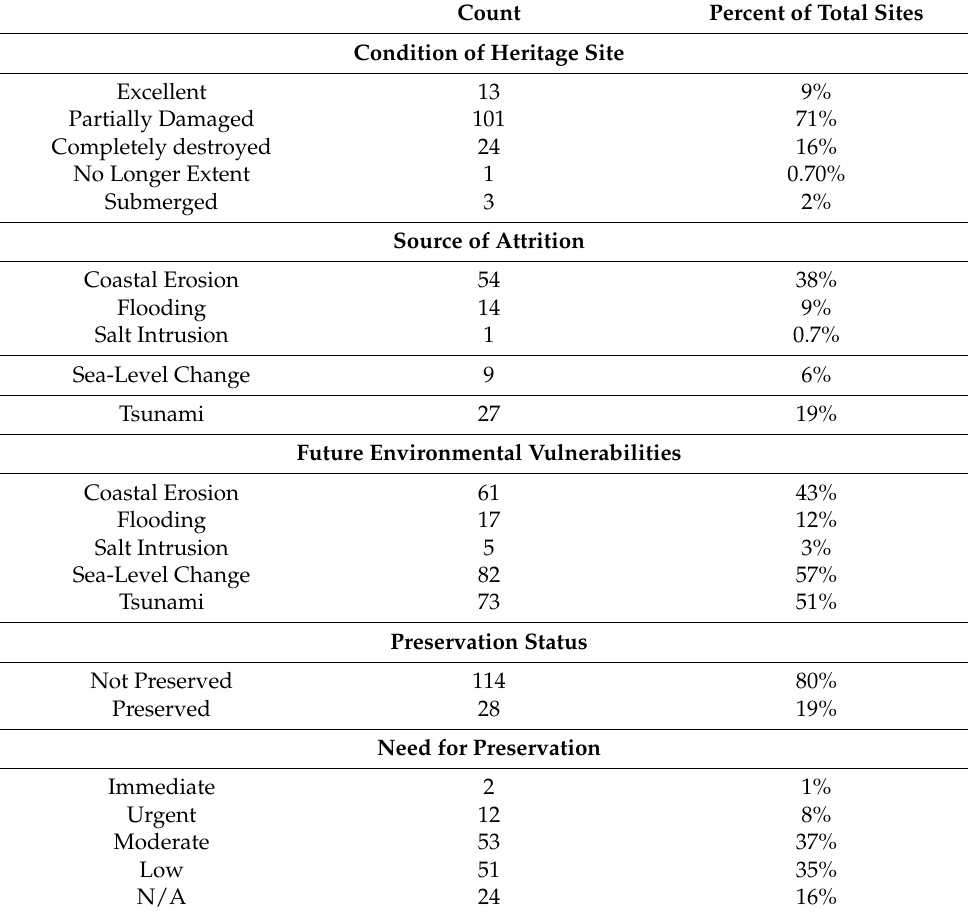
Table 2. Assessment of the condition, vulnerability to environmental stress, and preservation status for 146 heritage sites documented in Haa Alifu, Haa Dhaalu, Kaafu, Noonu, and Shaviyani atolls in the Maldives.